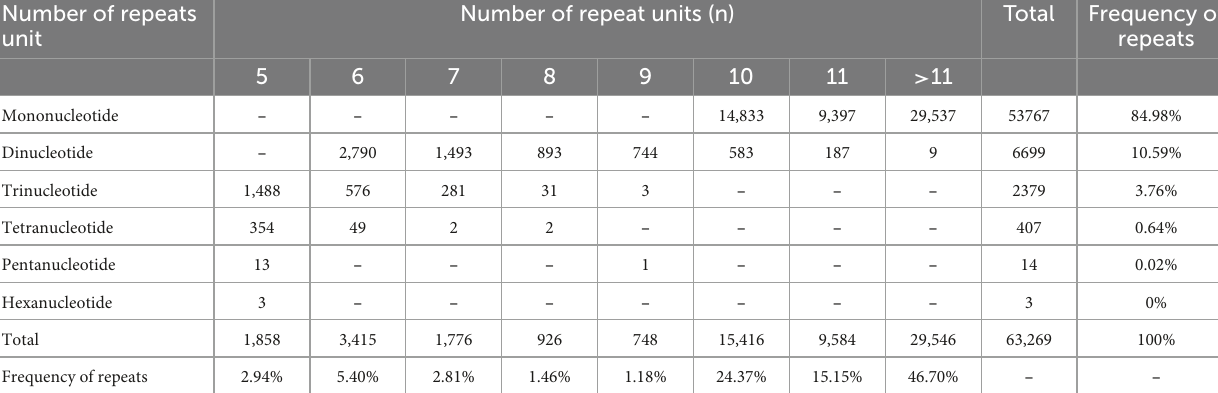
TABLE 4 The statistical results of expressed sequence tag-Simple Sequence Repeats (EST-SSRs) different repeat type. Number of repeats Number of repeat units (n) Total Frequency of unit